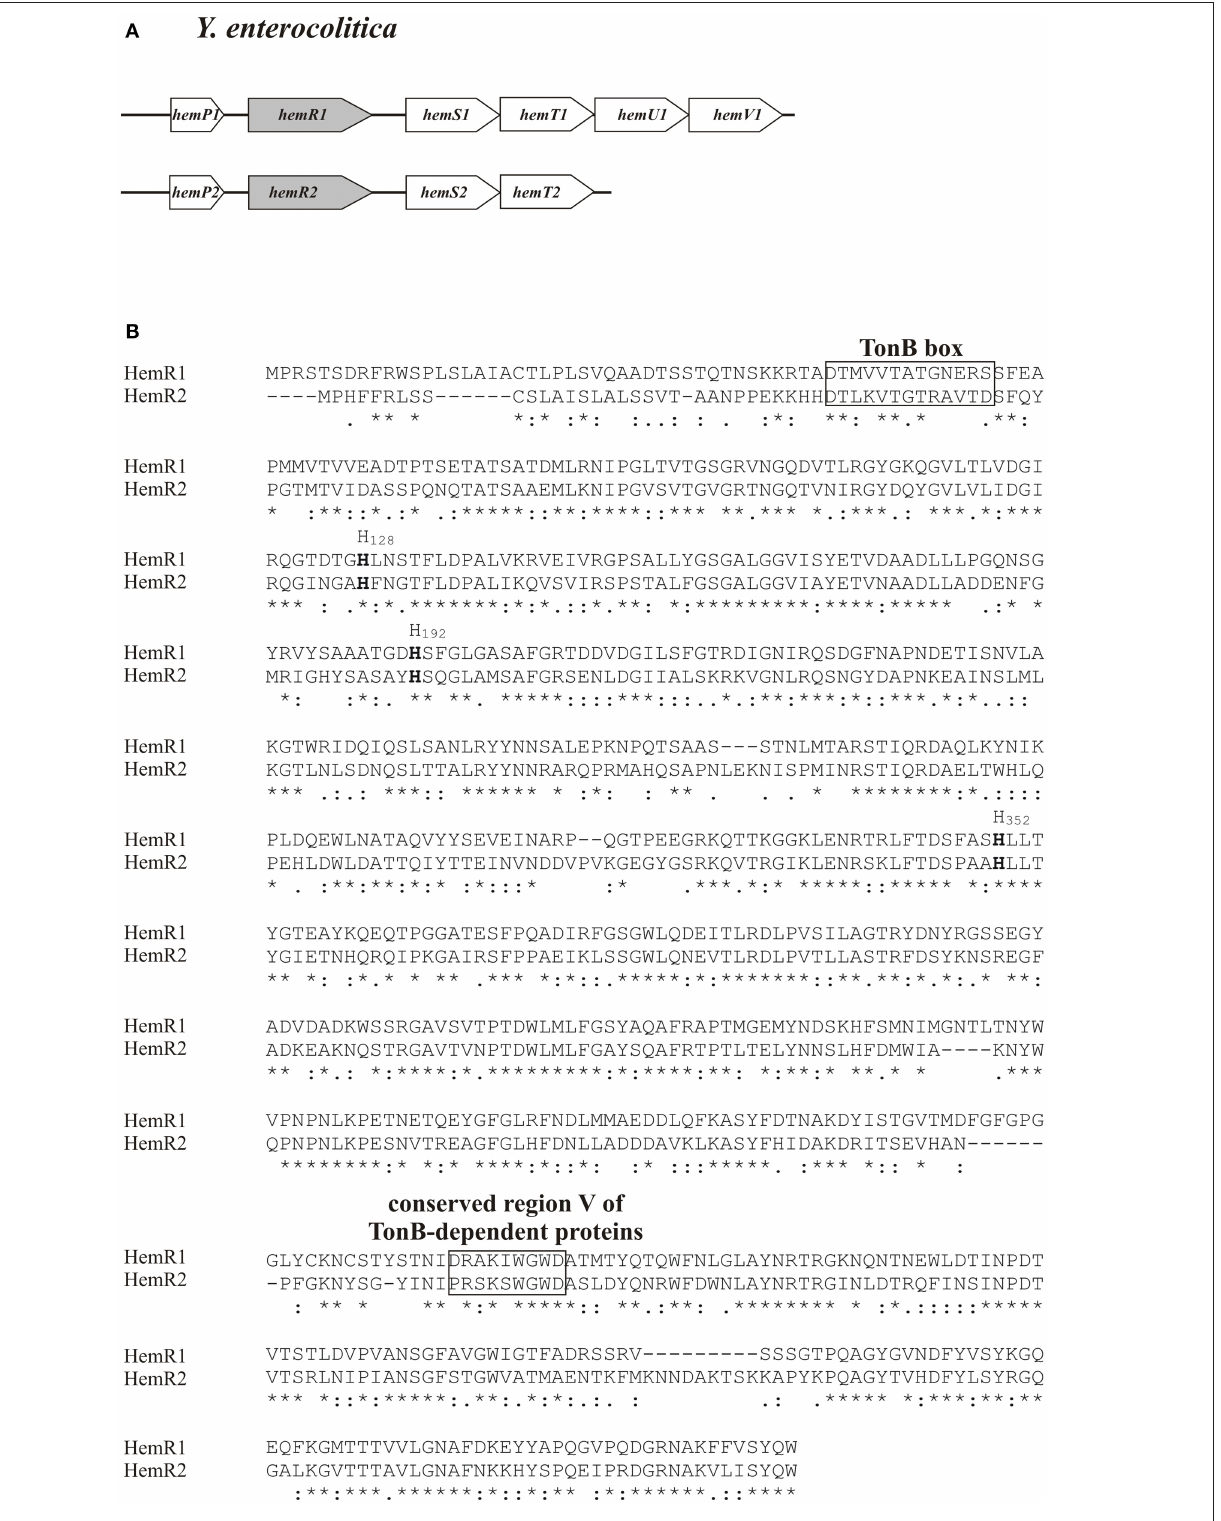
FIGURE 2 | Organization of two heme uptake loci of Y. enterocolitica Ye9 and comparison of the encoded HemR homologs. (A) Genetic maps of heme transport loci 1 and 2. (B) Alignment of HemR1 and HemR2. The conserved histidine residues are in bold, and the TonB box and region V characteristic of all TonB-dependent OM proteins are boxed. Conserved amino acids are indicated by